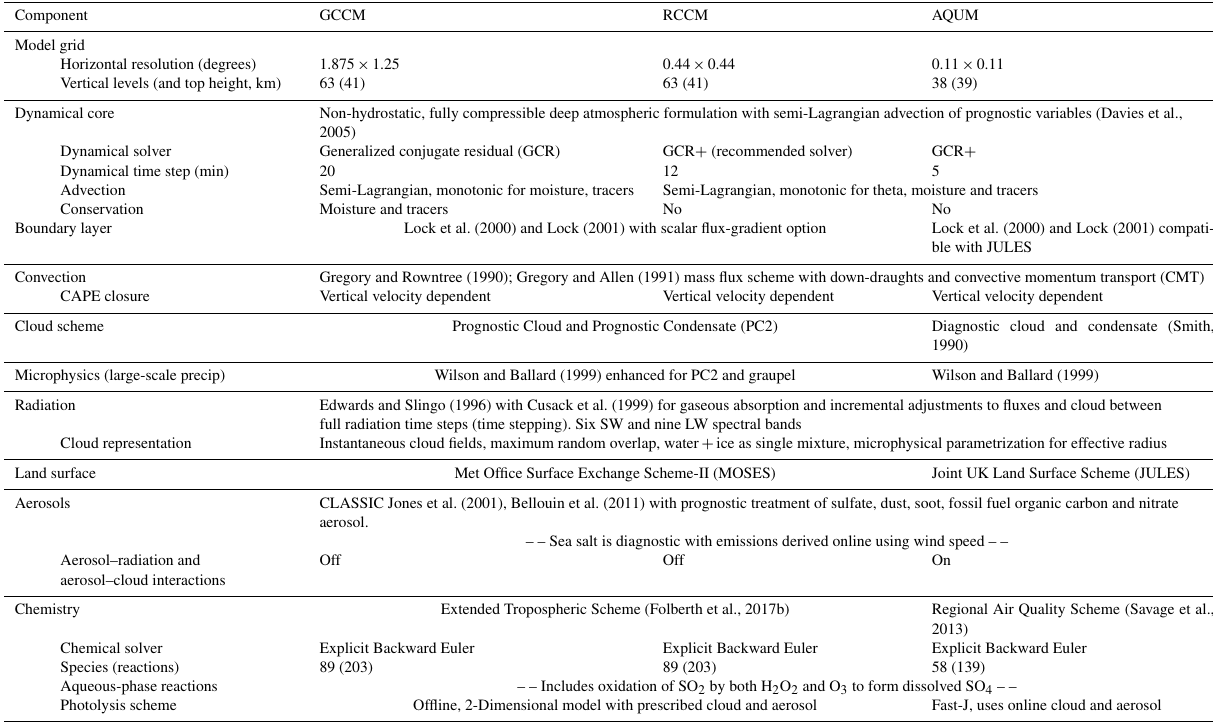
Table A1. Summary of model configuration settings used in the GCCM, RCCM, and AQUM models.